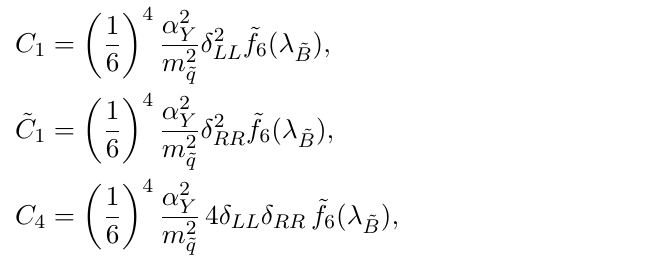
system is shown as an example, the K 0 and B 0 s d L or R R (and not L R ) squark (cid:0) (cid:0) (cid:0)